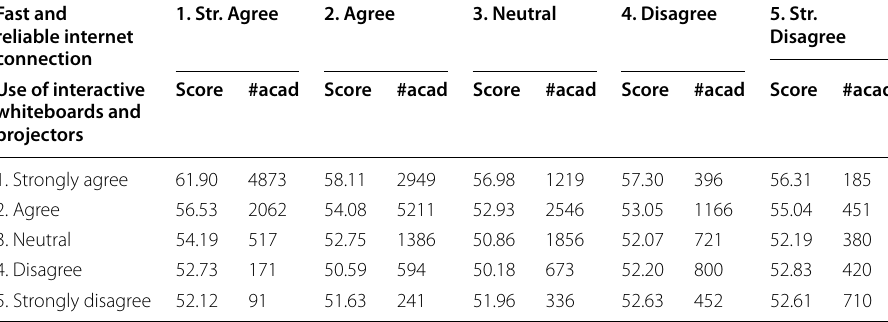
#acad means number of academics; Str. means